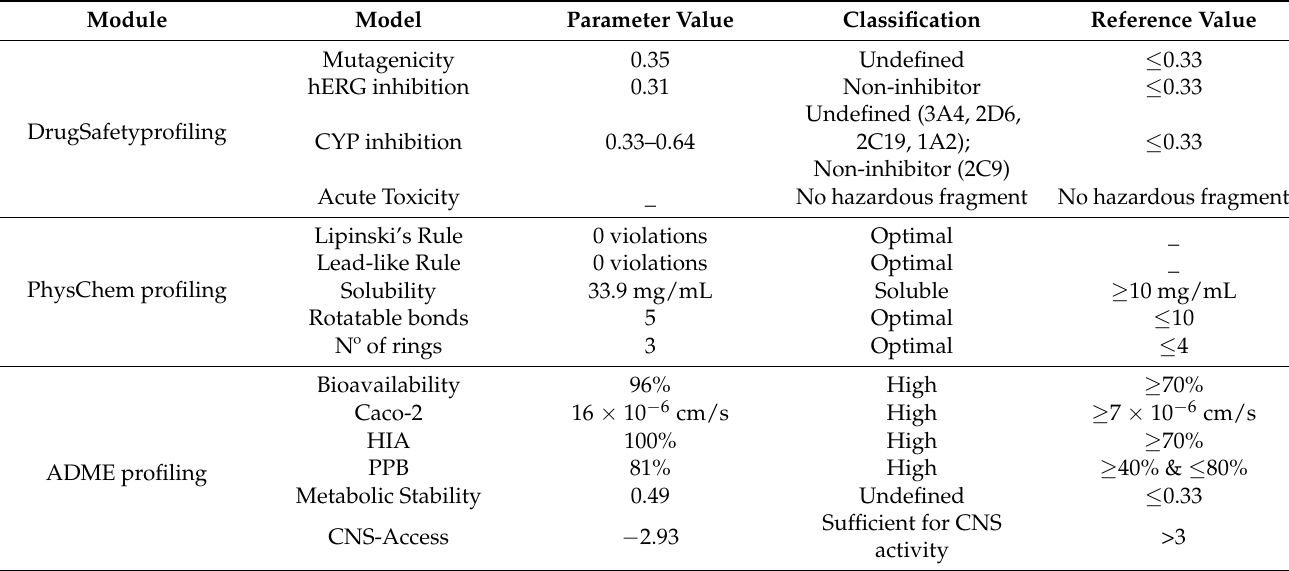
Table 6. ACD/Percepta analysis for the SBL-1